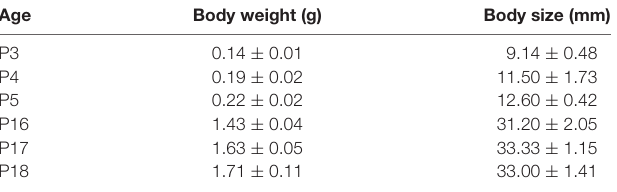
TABLE 1 | Age, body weight and size of opossums used in this